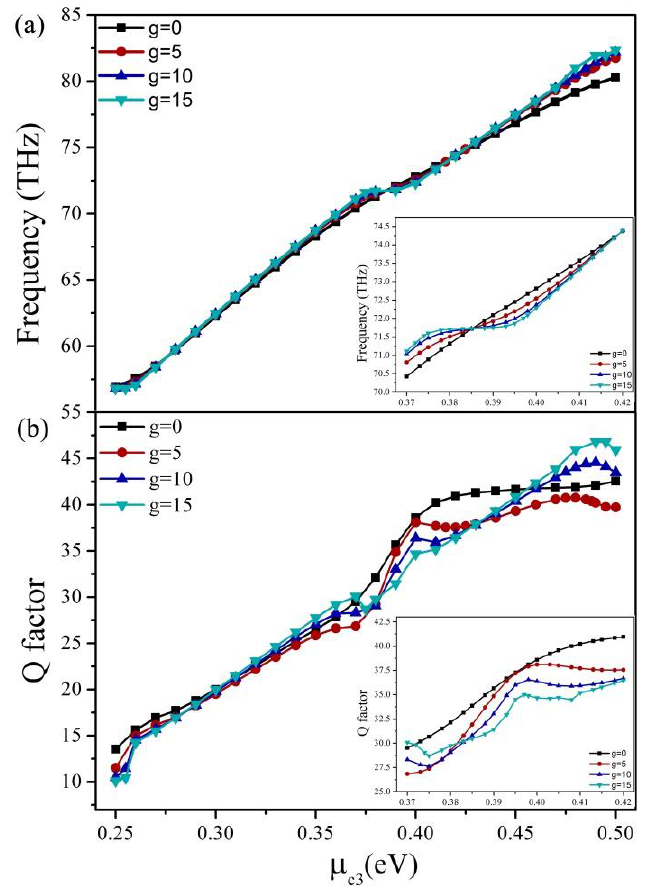
Figure 8. The resonant frequency and the corresponding Q factor as a function of chemical potential µ c3 with various gap distances. The insets show the details with a chemical potential from 0.39 to 0.41 eV. ( a ) Resonance frequency; ( b ) Q factor.